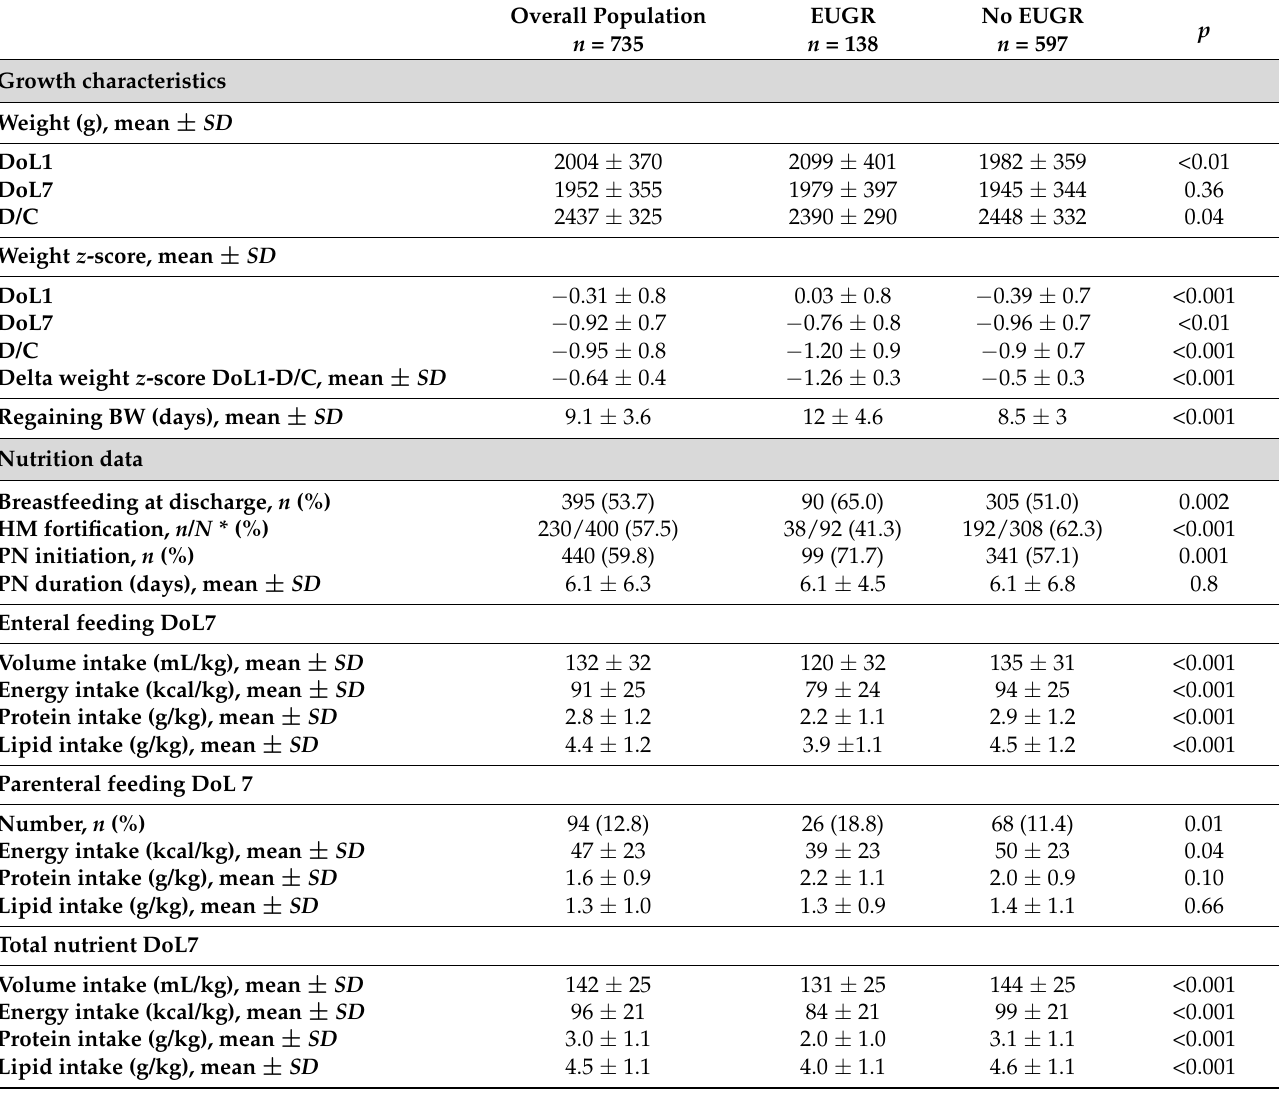
Table 2. Nutrients and growth of the study population according to EUGR. Overall Population n = 735